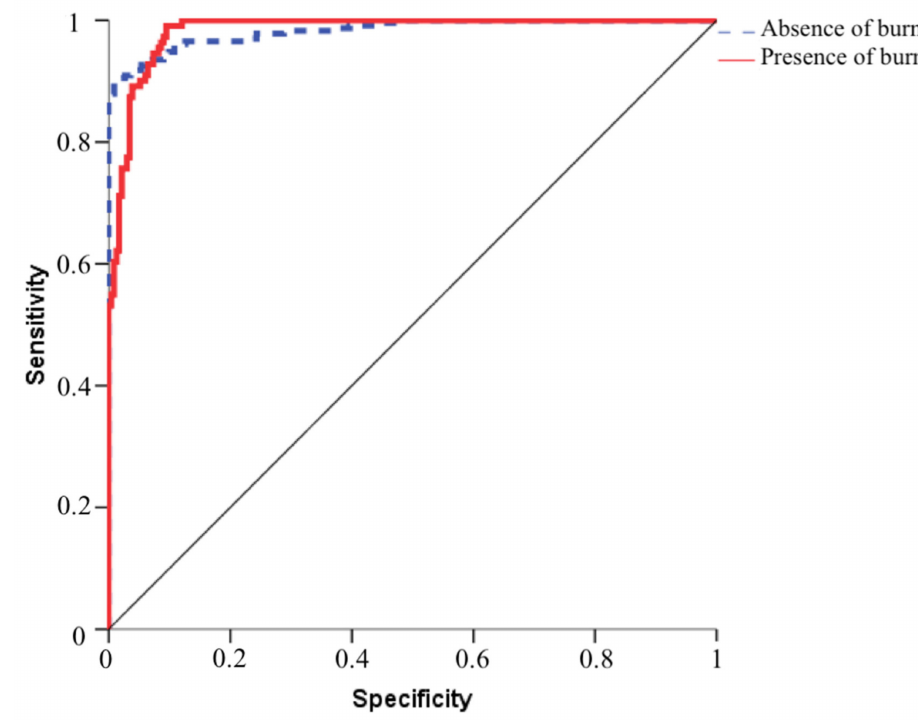
Figure 2. Sensitivity of the artificial neural network.